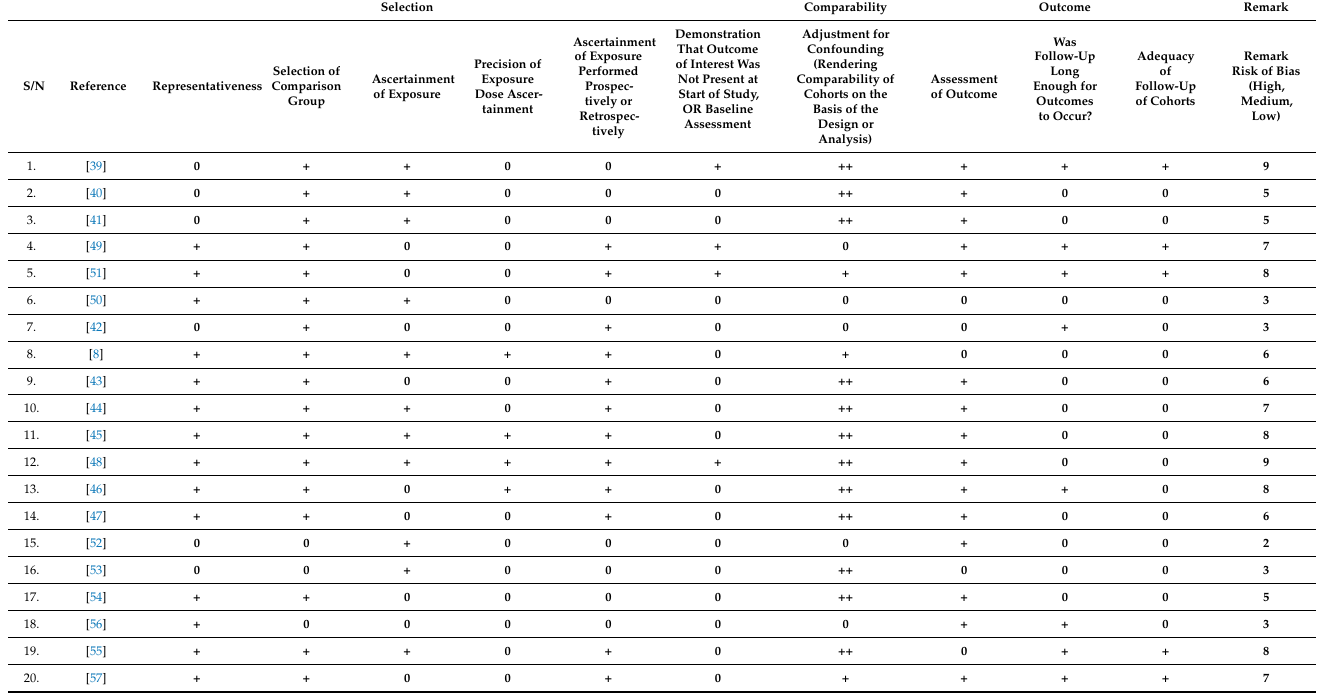
Table 3. Quality Assessment Using Newcastle–Ottawa Scale for Observational Studies